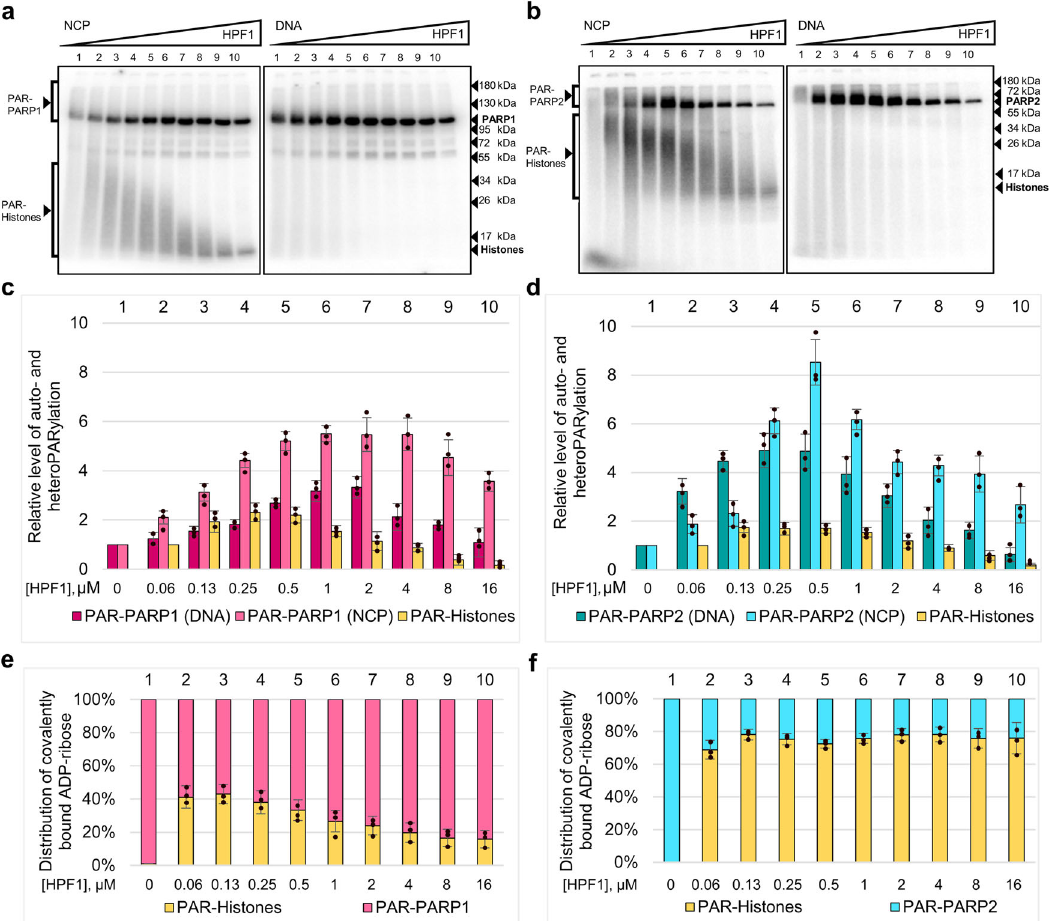
Fig. 2 HPF1 stimulates the autoPARylation of PARP1 and PARP2 and heteroPARylation of histones. Covalent binding of 32 P-labelled ADP-ribose to proteins was performed by incubation of PARP1 ( a ) and PARP2 ( b ) (500 nM) with [ 32 P]NAD + (1 μ M), in the presence of DNA (250 nM) or NCP (250 nM) (as speci fi ed above the autoradiograms) and increasing concentrations of HPF1 (from 60 nM to 16 μ M); the products were separated in 10% ( a ) and 20% ( b ) SDS-PAG. The positions of PARylated proteins and their native forms (and molecular weight markers) are indicated on the left and right sides of the autoradiograms. c , d Histograms present relative labelling levels (the mean ± SD of three independent measurements and individual data points) of PARP1, PARP2, and histones determined by normalization of the ADP-ribose amounts covalently bound to the given protein in the presence of HPF1 (samples 2 ‒ 10 for PARP1/PARP2 and samples 3 ‒ 10 for histones) to the respective amount in the absence of HPF1 or its minimal concentration (sample 1 for PARP1/PARP2 and sample 2 for histones). e , f Histograms show distribution (%) of the total amount of covalently bound [ 32 P]ADP-ribose in each sample between the modi fi ed PARP1(PARP2) and